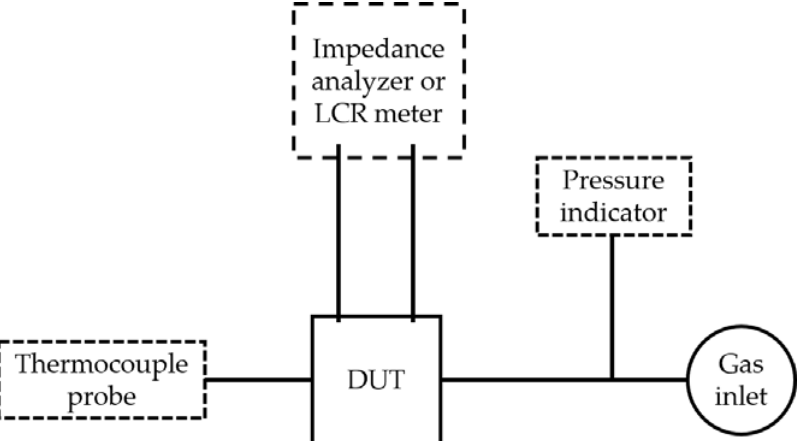
Figure 2. A sketch of the measurement set-up. The device under test (DUT), i.e., the sensor or free-standing BFO piezoelectric disc is electrically connected with an impedance analyzer or LCR meter. Temperature ( T ) and differential pressure ( p ) are monitored by the thermocouple probe and pressure indicator, respectively.